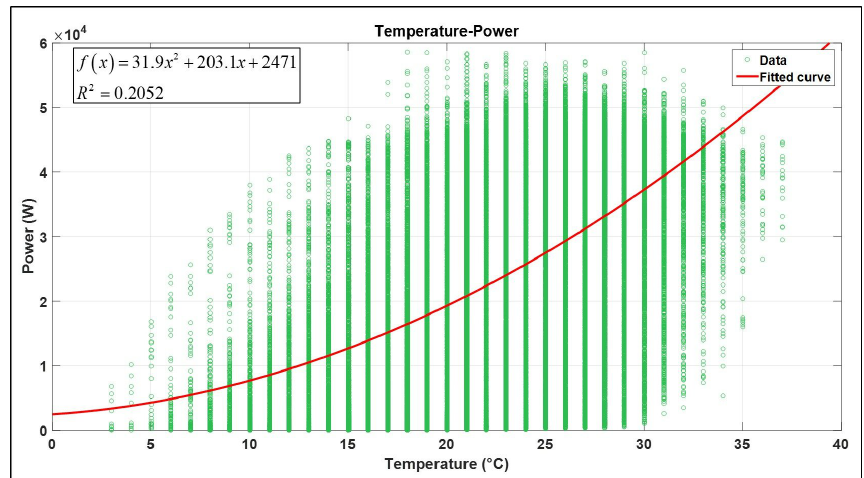
Figure 12. The Power vs. Temperature of MCS.